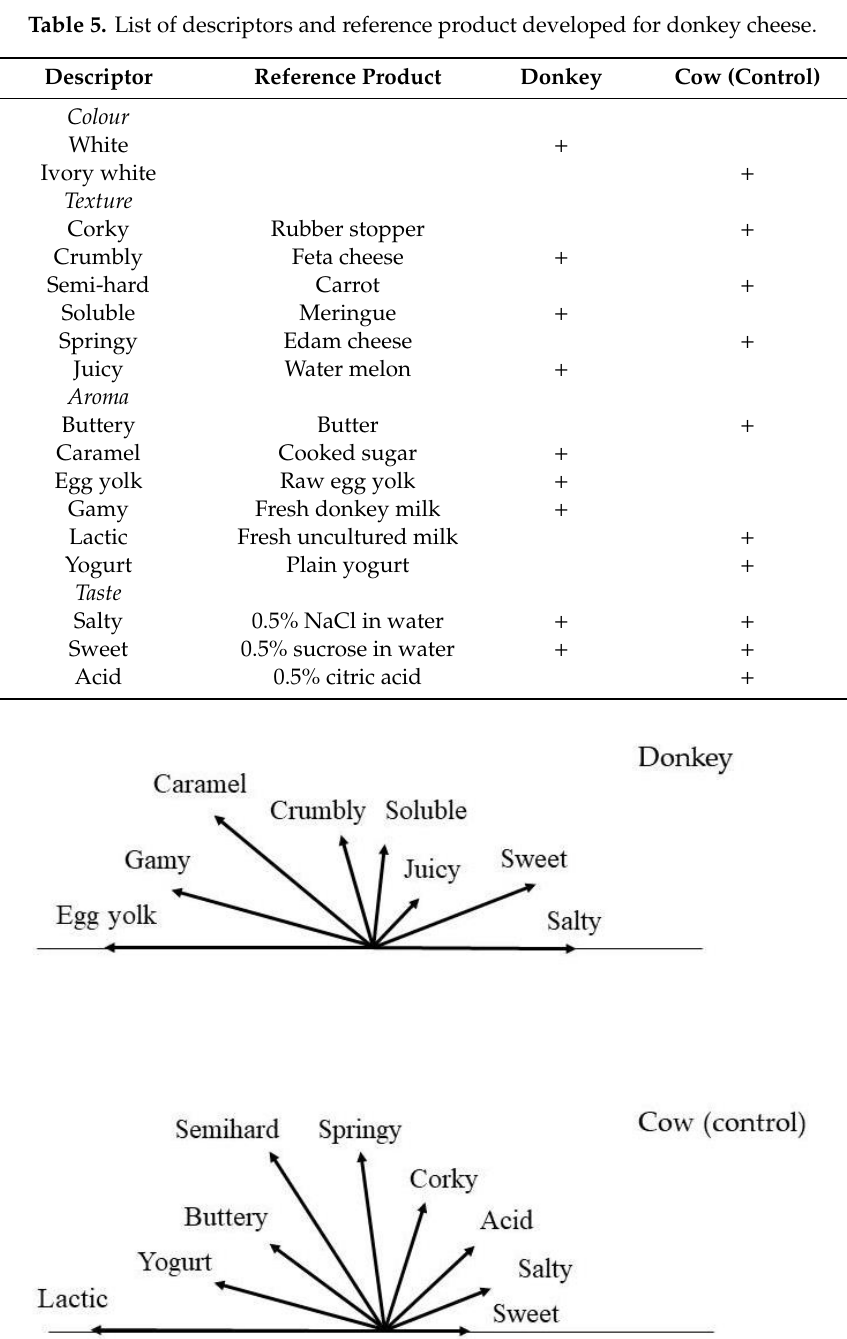
Figure 5. Flavour profile (aroma, texture and taste) of donkey and control cheese made with microbial rennet.